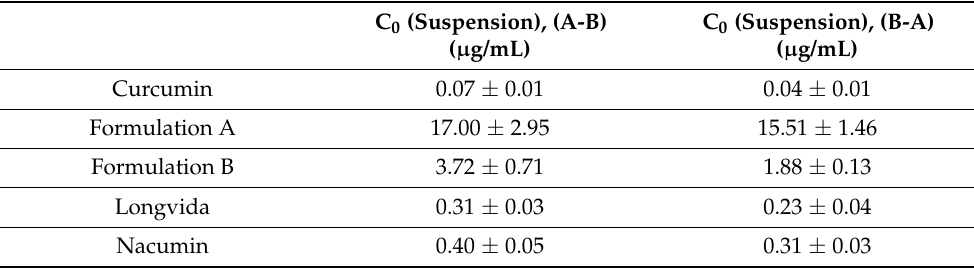
The values of the initial curcumin concentration dissolved in the donor chamber of each tested sample (C 0 (suspension)) are listed in Table 6. Formulation A showed the highest C 0 (suspension), (A-B) of 17 ± 2.95 µ g/mL and C 0 (suspension), (B-A) of 15.51 ± 1.46 µ g/mL, which were significantly higher than other tested samples ( p ≤ 0.05). Formulation B exhibited the second highest of C 0 (suspension), (A-B) of 3.72 ± 0.71 µ g/mL and C 0 (suspension), (B-A) of 1.88 ± 0.13 µ g/mL, which were significantly higher than Longvida, Nacumin ® and commercial curcumin ( p ≤ 0.05). No significant differences between the Longvida, Nacumin ® and commercial curcumin in terms of C 0 (suspension), (A-B) ( p > 0.05) and C 0 (suspension), (B-A) ( p > 0.05). Table 6. Initial curcumin concentration dissolved in donor chamber (C 0 suspension) ( n = 9, mean ± SD). C 0 (Suspension), (A-B)